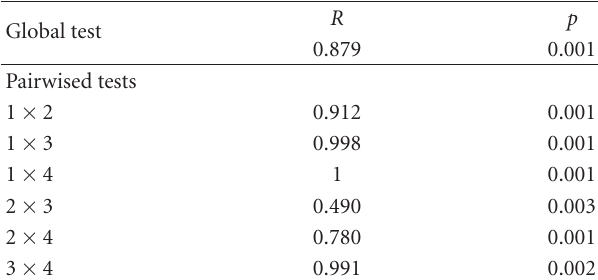
Table 2: Diversity data within the ten sampling sites: Shannon index ( H (cid:3) ), Species Richness ( S ), and Pielous’s Evenness ( J ); W99 = winter 1999, W00 = winter 2000, S00 = summer 2000, S02 =